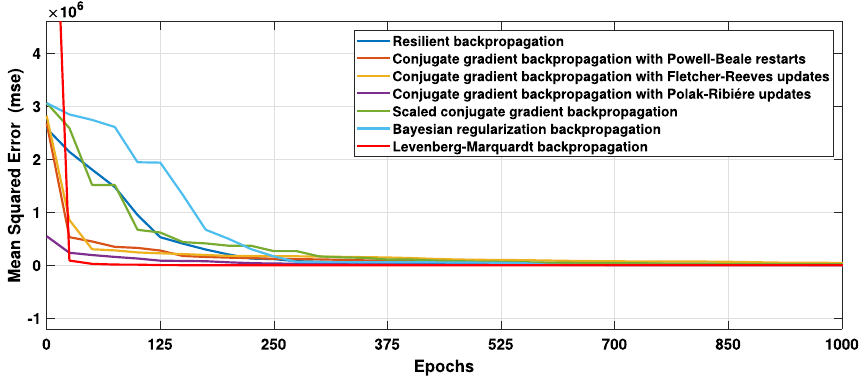
Figure 10. Errors graphs for